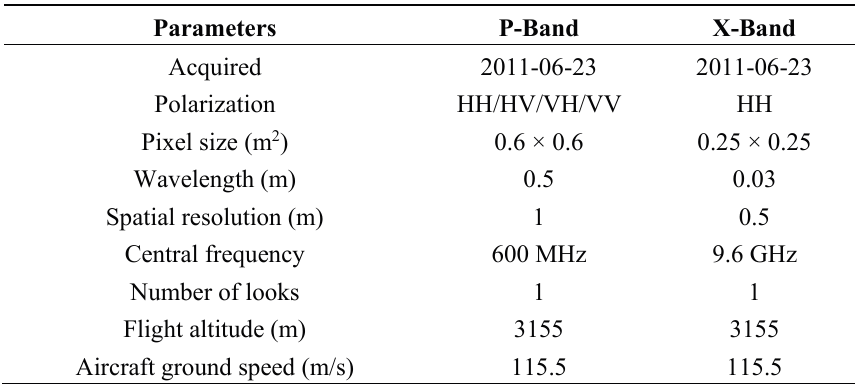
Table 1. CASMSAR dataset